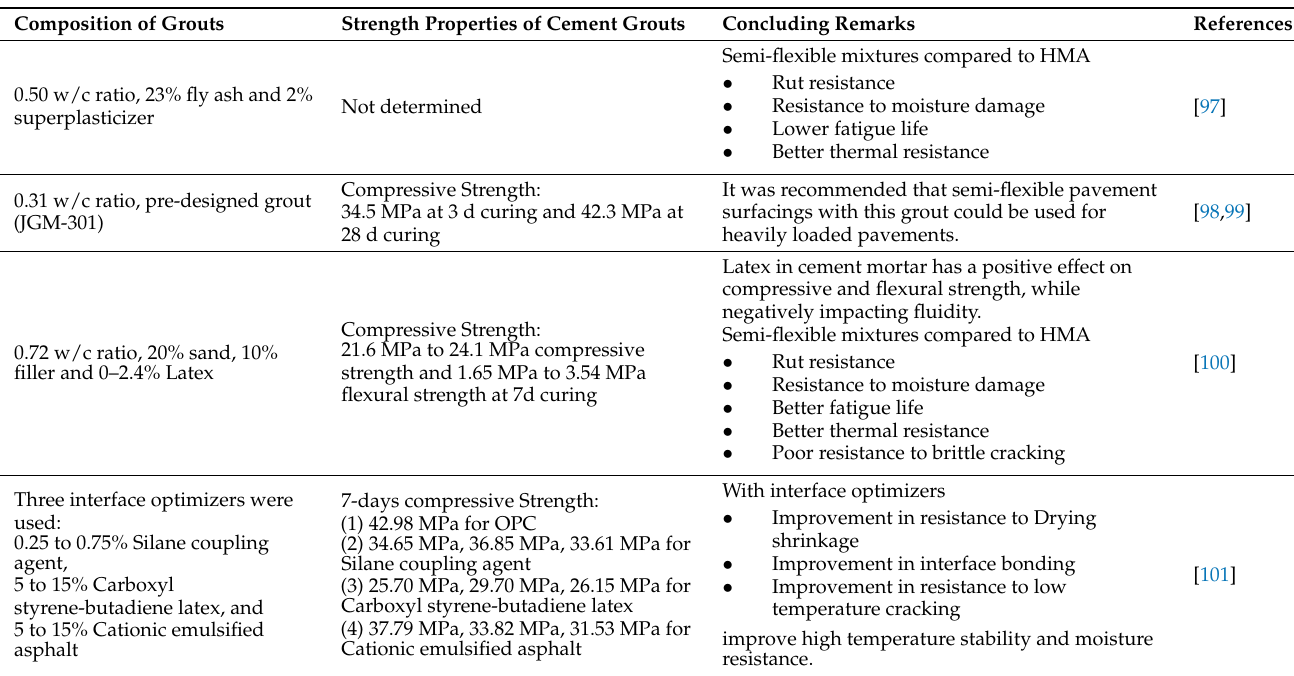
Table 9. Description of cement grouts from the